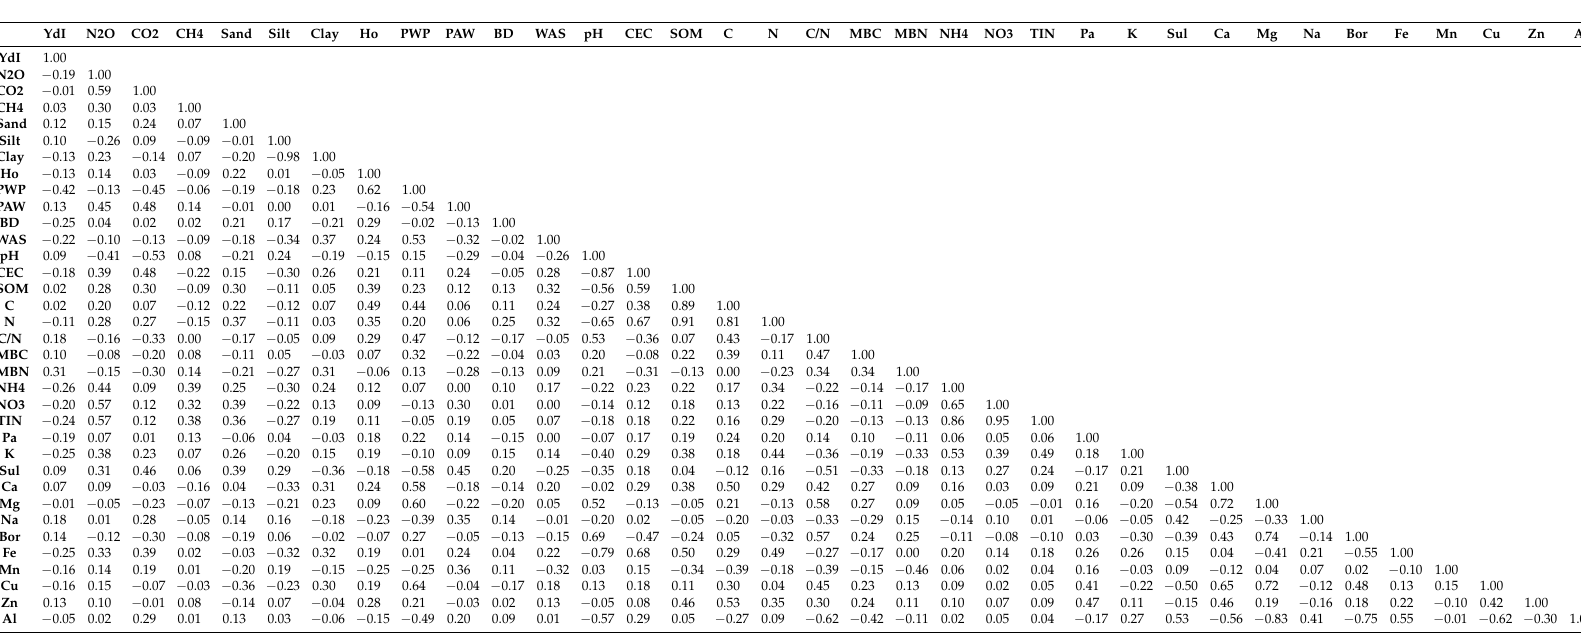
Table A9. Pearson correlation matrix among greenhouse gas emissions, yield index, and soil physical and chemical properties from Monmouth, IL. Variable include yield index (YdI), nitrous oxide (N 2 O), carbon dioxide (CO 2 ), methane (CH 4 ), yield index (YdI), sand, silt, clay, average soil moisture (Ho), permanent wilting point (PWP), plant available water (PAW), bulk density (Bd), water aggregate stability (WAS), pH, cation exchange capacity (CEC), soil organic matter (SOM), carbon (C), nitrogen (N), carbon to nitrogen ratio (C/N), microbial biomass carbon (MBC), microbial biomass nitrogen (MBN), soil ammonia intensity (NH 4 ), soil nitrate intensity (NO 3 ), total soil nitrogen intensity(TIN), available phosphorus (Pa), potassium (K), sulfur (S), calcium (Ca), magnesium (Mg), sodium (Na), boron, (B), iron (Fe), manganese (Mn), copper (Cu), zinc (Zn), and aluminum